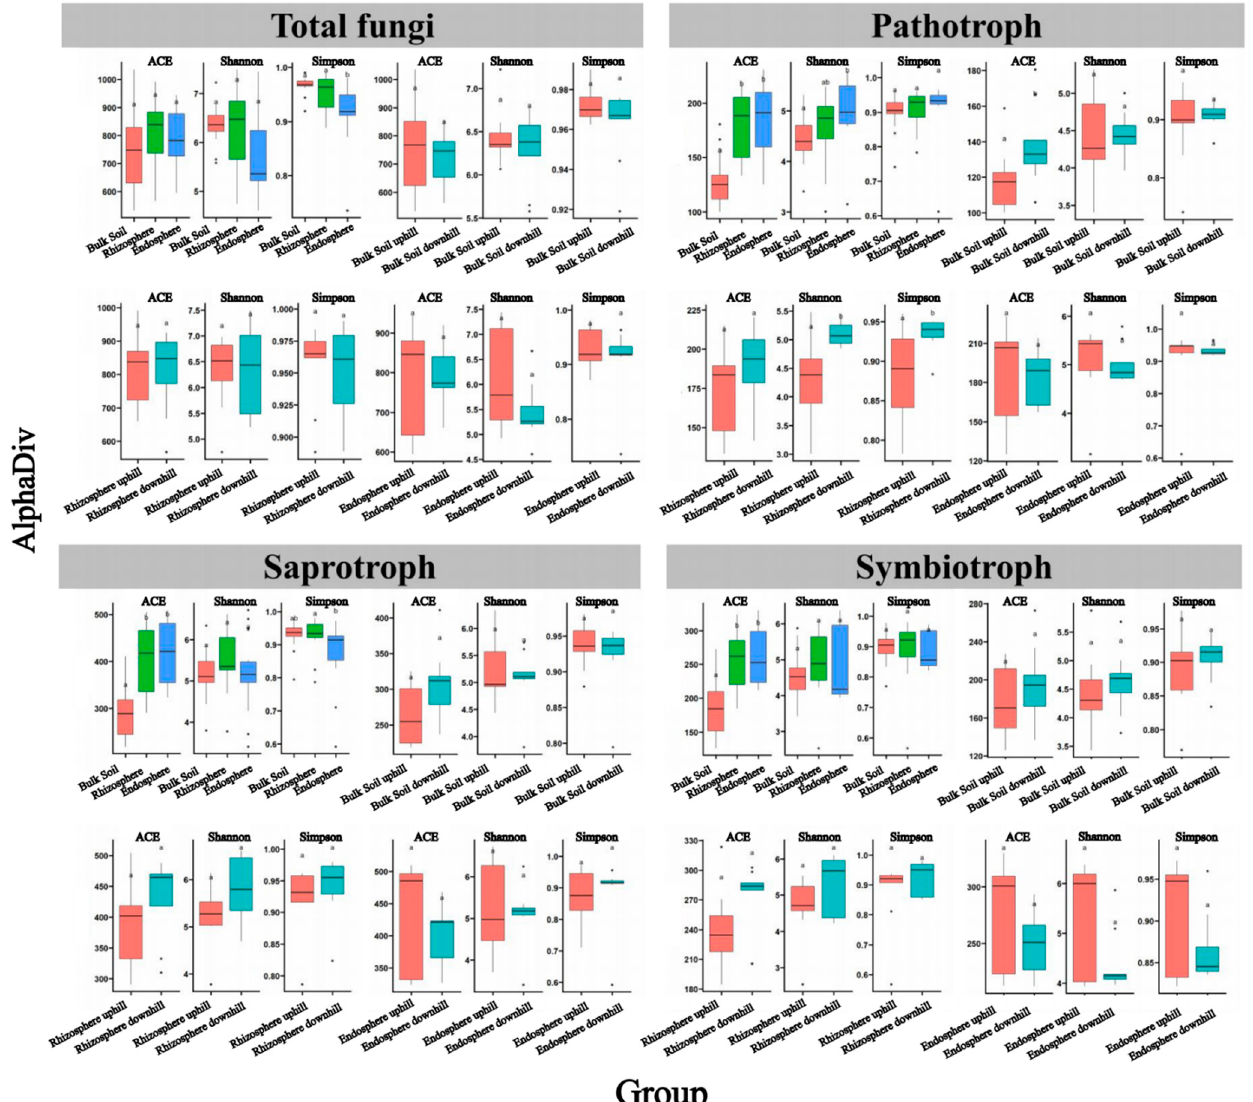
Figure 2. Alpha diversity indices of total fungi, pathotroph, saprotroph, and symbiotroph in the root endosphere, rhizosphere, and bulk soil samples. Abundance-based coverage estimator (ACE), Shannon index, and Simpson index are shown. Different lowercase letters indicate significant differences at p < 0.05.